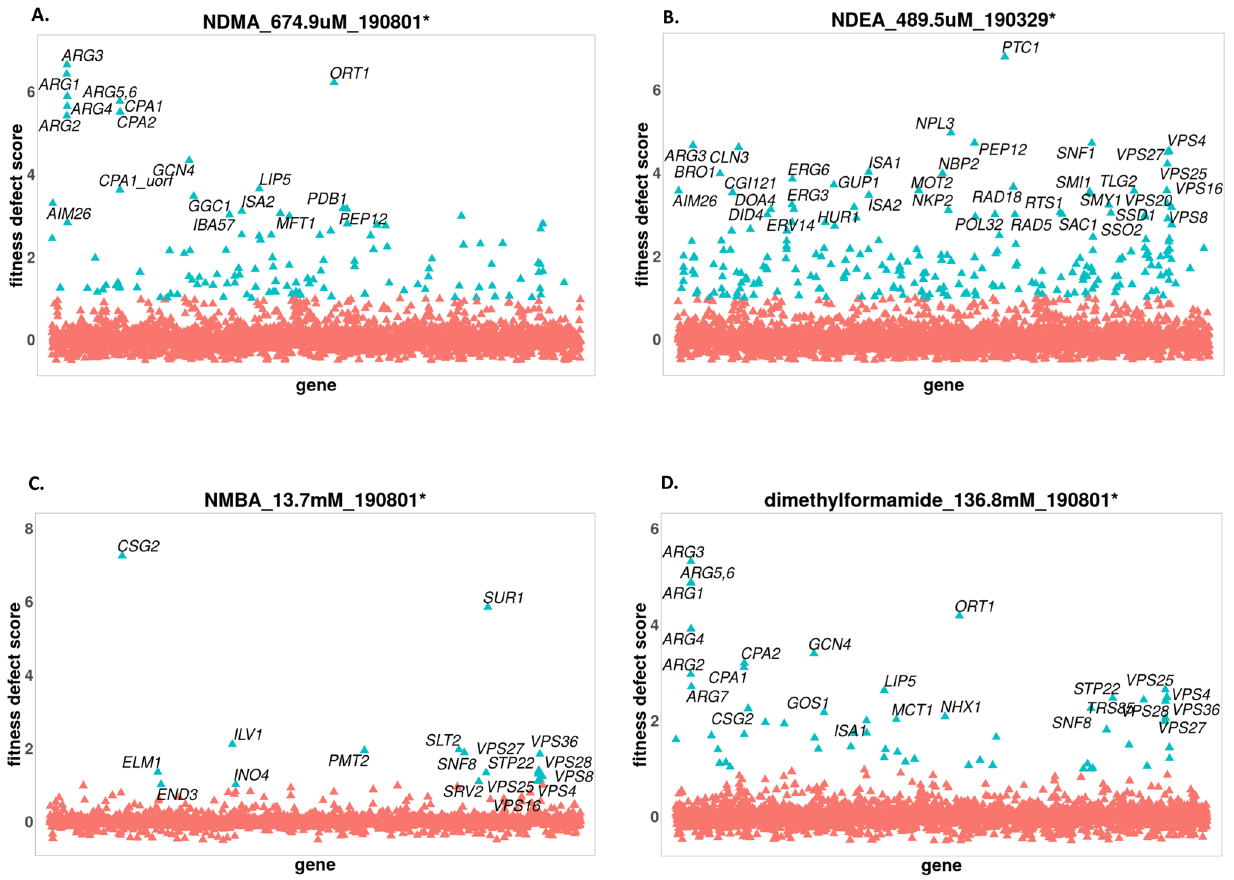
Figure 2. Fitness profiles showing genes (via deletion strains) affected by nitrosamines and related compounds. Genes (arranged alphabetically) are plotted on the horizontal axis versus their corresponding fitness defect (FD) scores on the vertical axis. Sensitive strains have a positive FD score, while resistant strains have a negative FD score. ( A ) Sensitive strains affected by NDMA include those lacking ARG1 , ARG3 , GCN4 , LIP5 , AIM26 etc. ( B ) Genes affected by NDEA (via effect on their deletion strains) are PEP12 , ARG3 , SNF1 , BRO1 , among others. ( C ) CSG2 , SUR1 , ILV1 , PMT2 etc. have their deletion strains affected by NMBA. ( D ) DMF was sensitive to strains lacking the following genes ARG3 , GCN4 , ORT1 , SNF8 etc. The concentration at which the compound was screened is indicated. Not all strains (genes) with significant FD scores are labelled. Fitness profiles